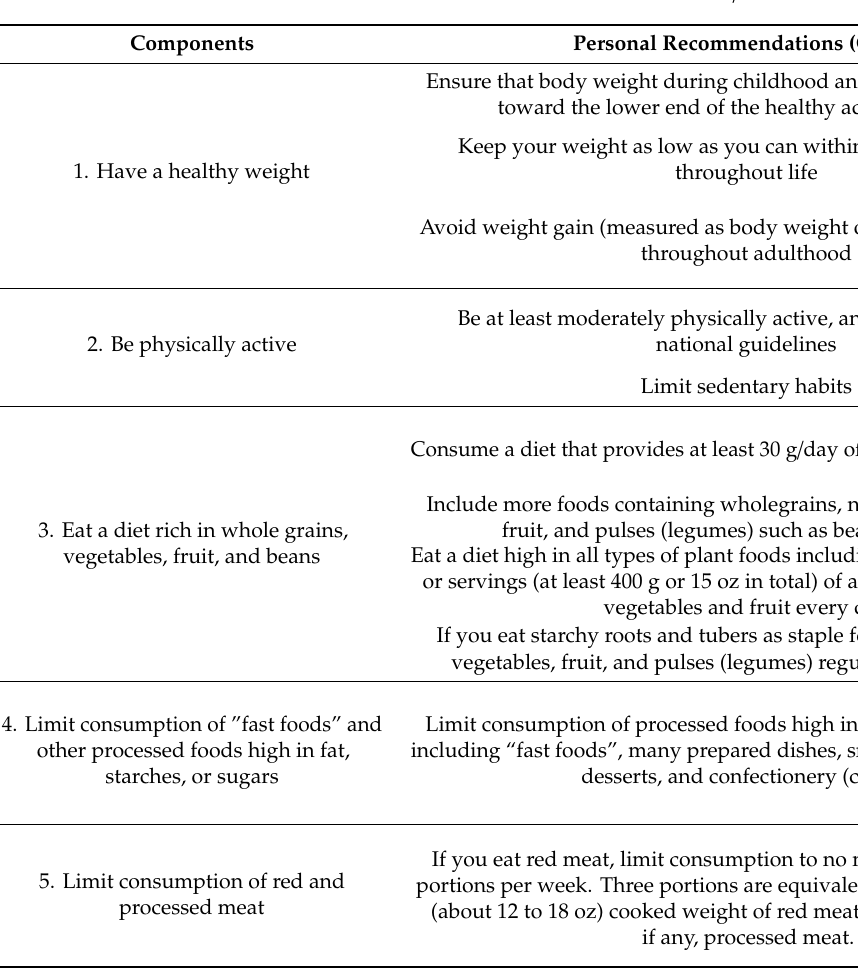
Table 1. The 2018 WCRF / AICR score construction in the CAPLIFE